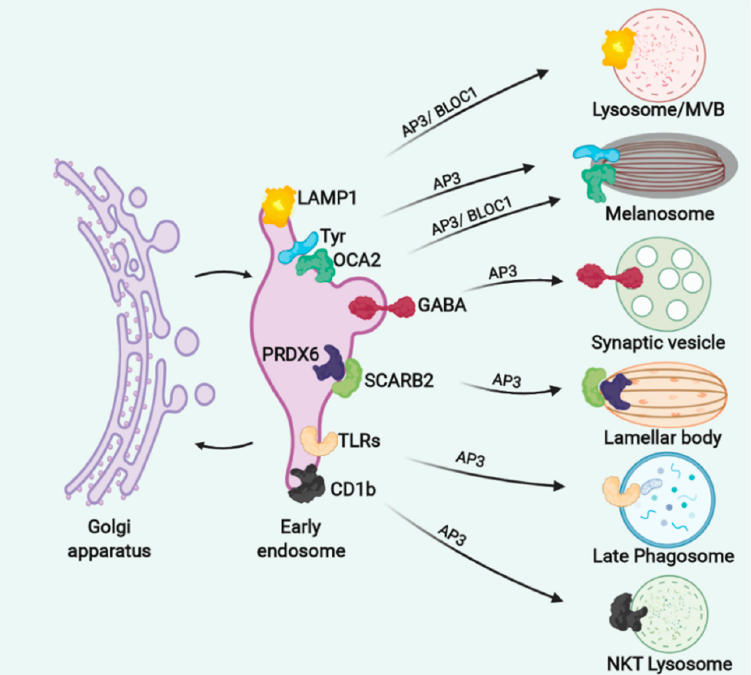
Figure 4. AP3 sorts different cargoes to lysosomes and LROs. AP3 is required for sorting of different cargoes from the early endosomes: LAMP1 to lysosomes, tyrosinase (TYR) and transporter oculocutaneous albinism 2 (OCA2) to maturing melanosomes, gamma-aminobutyric acid (GABA) to synaptic vesicles, peroxiredoxin 6 (PRDX6) to lamellar bodies through binding of the transmembrane protein LIMP-2/SCARB, toll-like receptors (TLRs) to maturing phagosomes and CD1b to natural killer T (NKT) cells. BLOC1 is involved together with AP3 in the delivery of LAMP1 to lysosomes and OCA2 to maturing melanosomes.